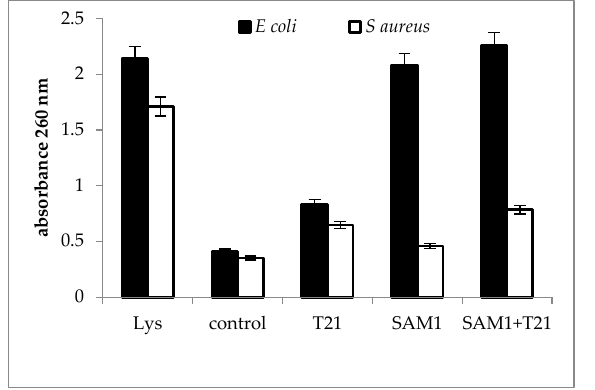
Figure 6. UV absorbance at 260 nm in S. aureus ATCC 33952 and E. coli ATCC 11229 cultures after treatment with T21, SAM1, and SAM1 + T21 (concentration of compounds and combinations: T21 0.5%; SAM1 1MIC; SAM1 1MIC + T21 0.5%).